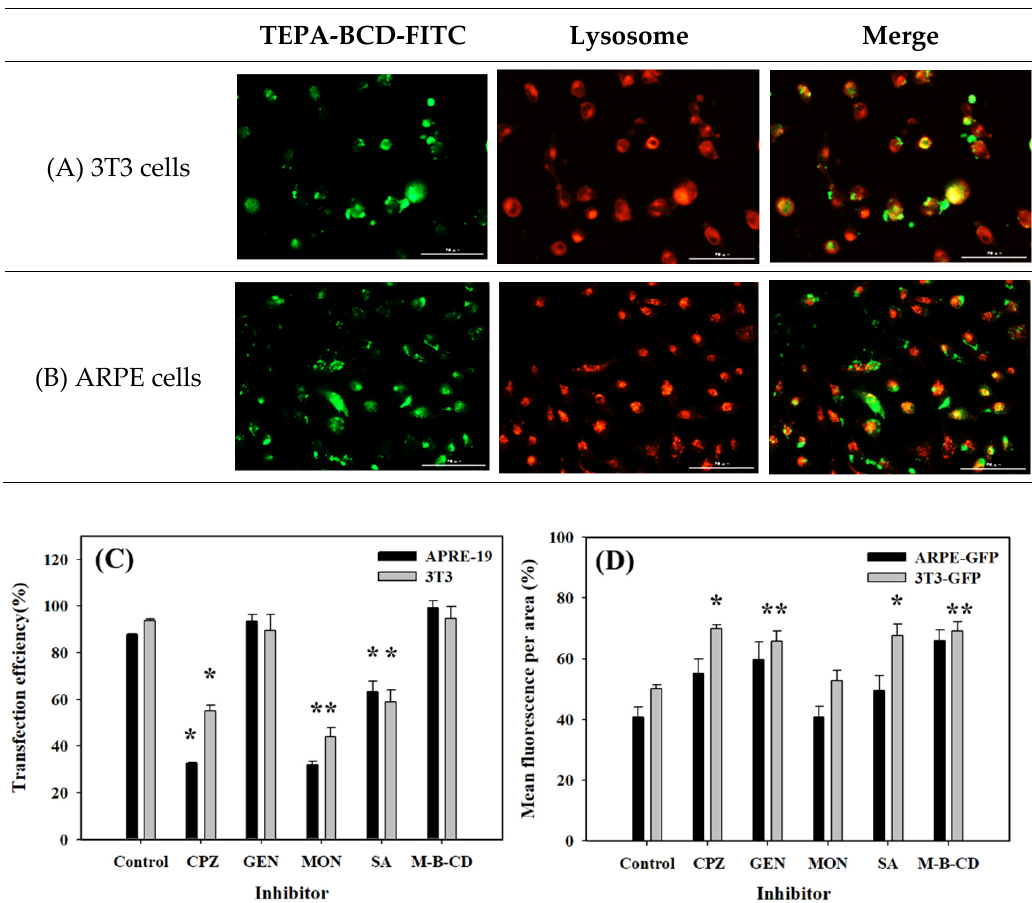
Figure 7. Imaging of the cellular uptake of FITC-labeled TEPA-BCD in ( A ) 3T3 cells and ( B ) ARPE cells. ( C ) GFP plasmid transfection of TEPA-BCD/plasmid DNA in ARPE and 3T3 cells, and ( D ) GFP knockdown of TEPA-BCD/siRNA in ARPE-GFP and 3T3-GFP cells was determined. Colocalization analysis of fluorescence images showed FITC signal (green) overlapped with Lysotracker Red (red). DNA transfection and siRNA silencing under conditions that perturbed endocytic pathways. Cells were treated with endocytic inhibitors (chlorpromazine (CPZ), monensin (Mon), genistein (Gen), methyl- β -cyclodextrin (MCD), and sodium azide (SA)) (Table 1)) for 3 h. Control groups were nontreated cells. The scale bar is 200 μ m. The symbol * indicates p < 0.05 comparing TEPA-BCD to nontreated control. Error bars represent the standard deviation from 8 images.